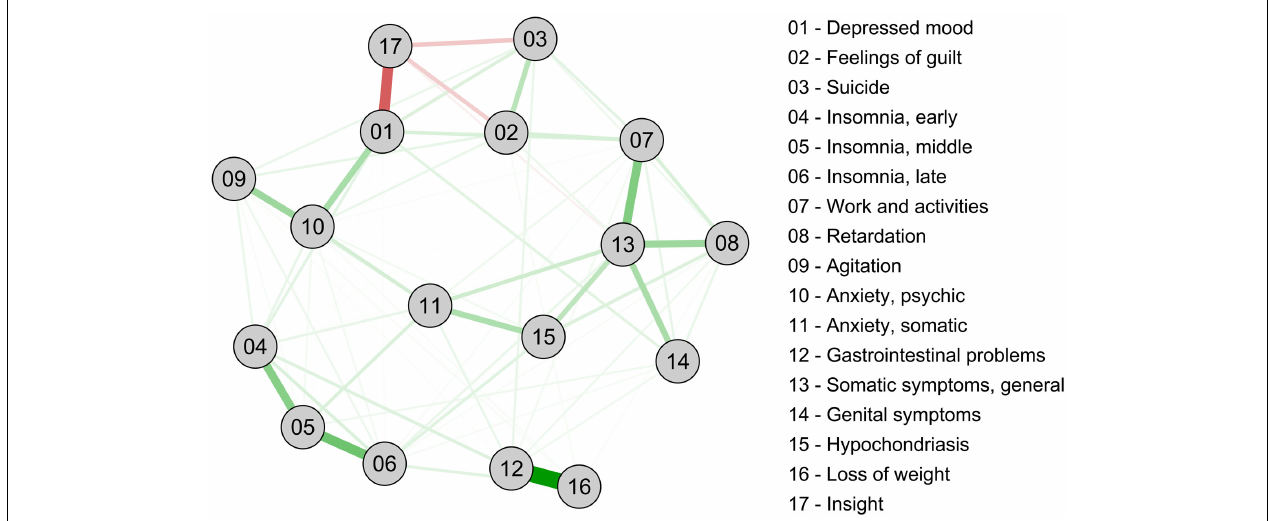
FIGURE 1 | Network of 17 HRSD depression symptoms . Green lines represent positive associations, red lines negative associations, and thickness and brightness of an edge indicate the strength of the